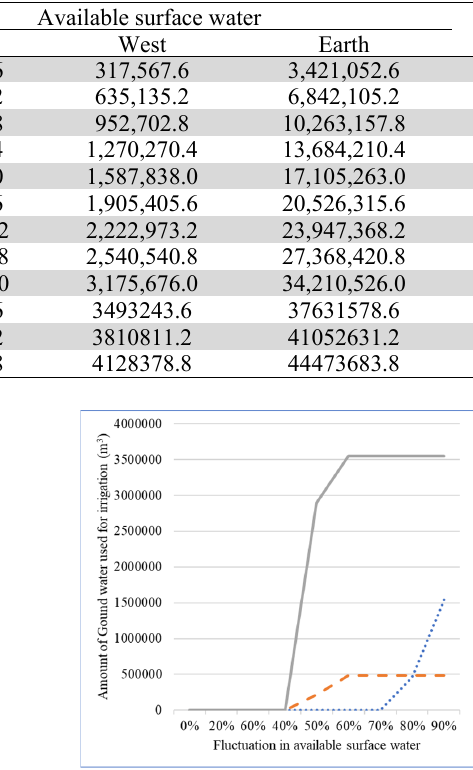
Fig. 5. Profit vs. the available amount of surface water (SW)